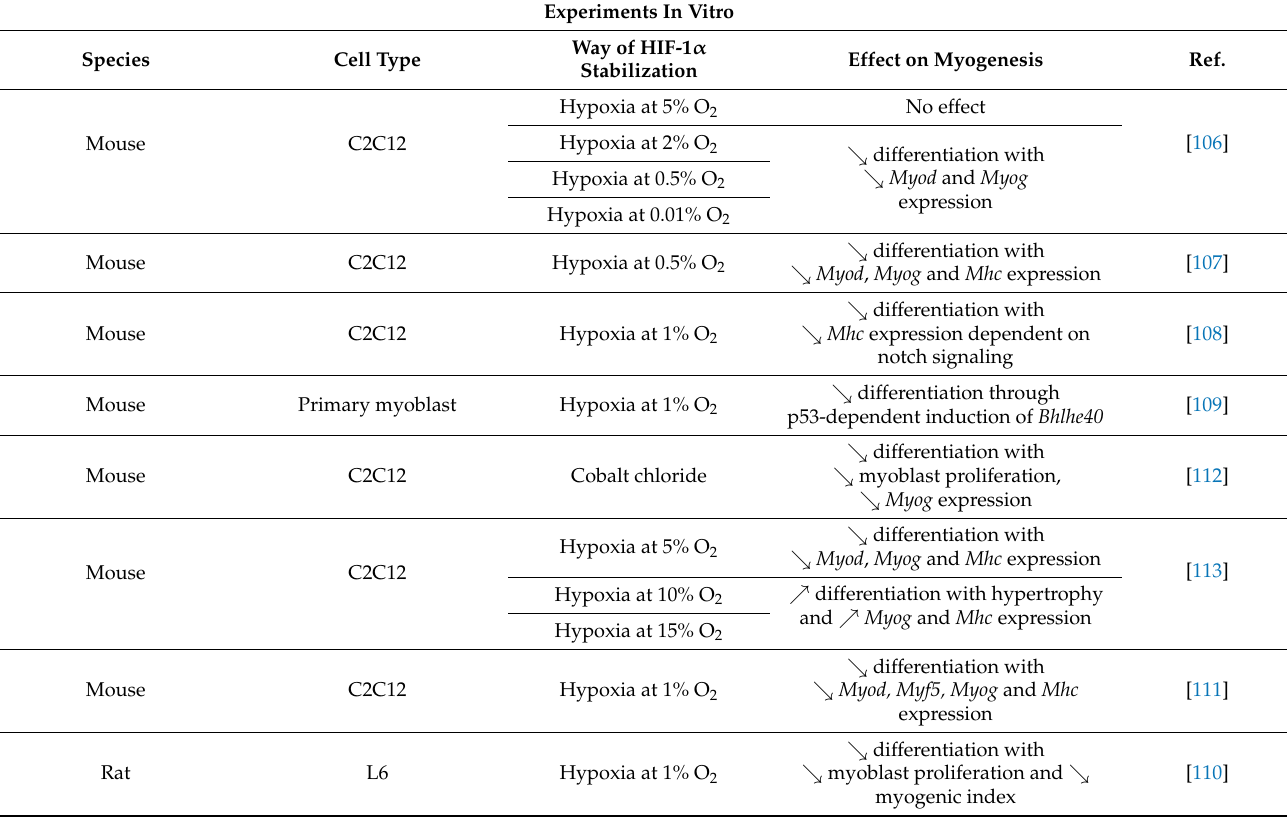
Table 3. Effect of hypoxia on myogenesis in